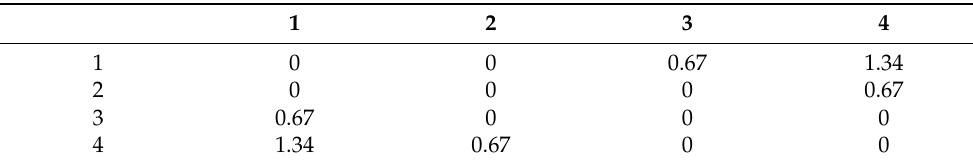
Figure 1. Flow chart of the proposed IPVH. Table 1. An illustration of the look-up table for dist()